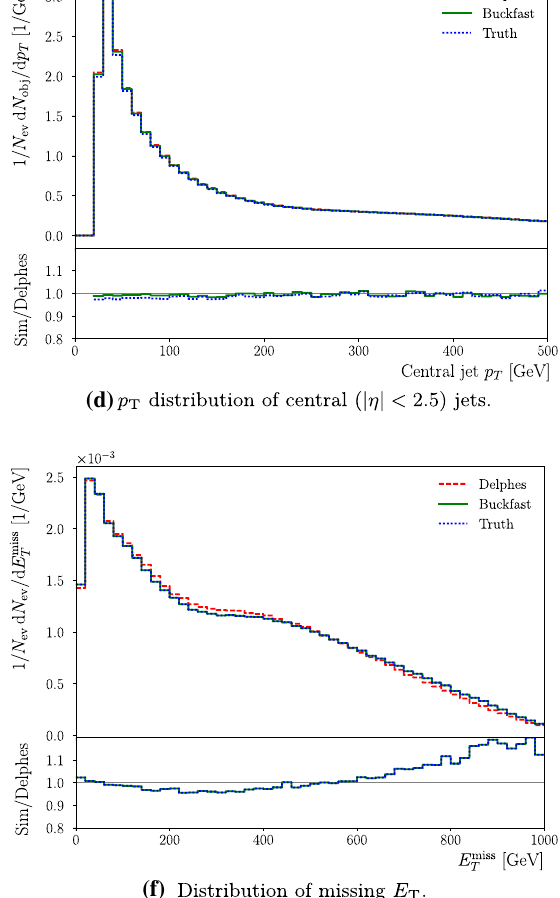
pointnearthecurrentATLASsearchlimit(seemaintext).Theratioplots are computed relative to Delphes , to best evaluate the performance